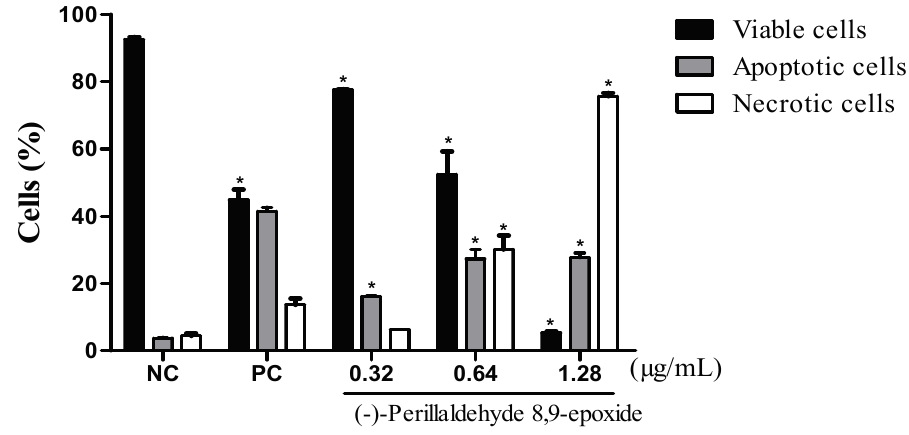
Figure 3. The effect of 16 on the viability of human leukemic cells (HL-60). Cell viability (viable cells-black bar; apoptotic cells-gray bar; and necrotic cells-white bar) was determined respectively by fluorescence microscopy using acridine orange/ethidium bromide after 24-h incubations. The data are presented as the mean values ± S.E.M. of three independent experiments performed in duplicate. The negative control was treated with the same vehicle (NC, 0.1% DMSO) that diluted the test substance. Doxorubicin (PC, 0.3 μ g/mL) served as the positive control. * p < 0.05 compared to negative control by ANOVA, followed by a Student Newman-Keuls